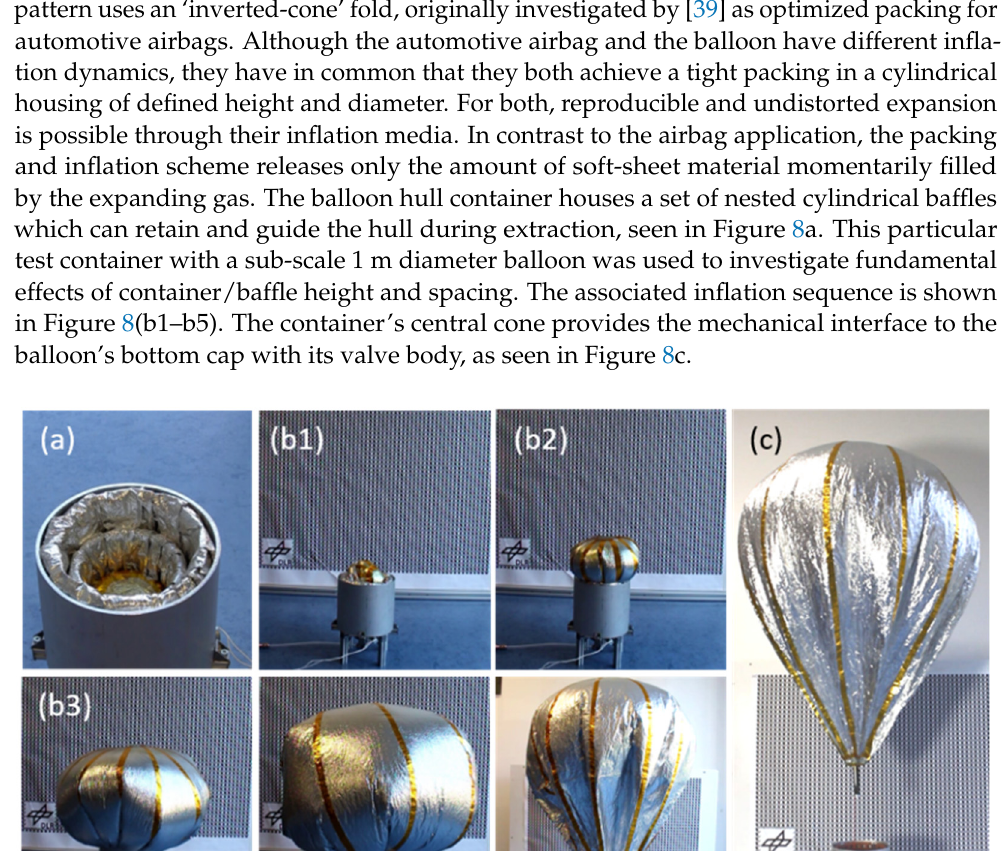
Figure 8. Folded and packed 1 m subscale balloon hull ( a ), image sequence ( b1 – b5 ) shows the inflation process. After completion, the release mechanism is triggered, and the valve body is pushed out of its restraint ( c ).